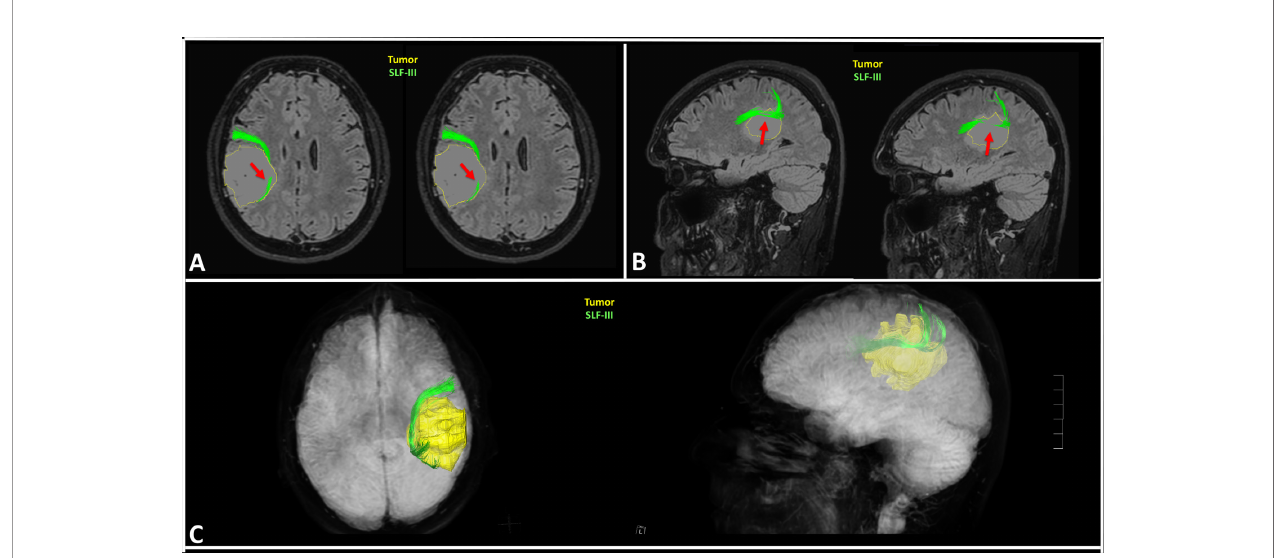
FIGURE 9 | Case example of the planning in a case of right fronto-parietal diffuse astrocytoma. The preoperative 3D reconstruction of the SLF-III showed it was in fi ltrated by the tumor. The green fi bers of the SLF-III are in fi ltrated by the medial (A) and superior (B) portion of the tumor as indicated by the red arrows; the 3D reconstruction con fi rmed the in fi ltration of the SLF-III, thus inducing neurosurgeon to plan a subtotal resection to preserve the VS network (C)